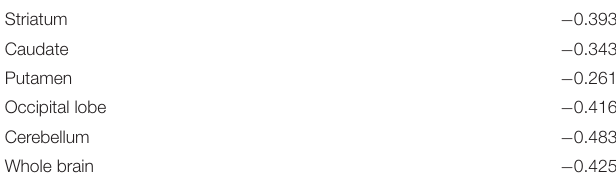
TABLE 4C | Annual decline rate (%) of volume for